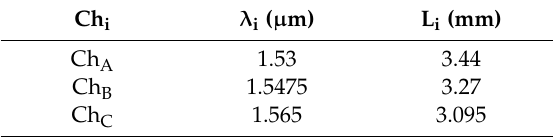
Figure 2. Schematic sketch of the 1 × 3 angled multimode interference (AMMI) demultiplexer at the x–z plane.